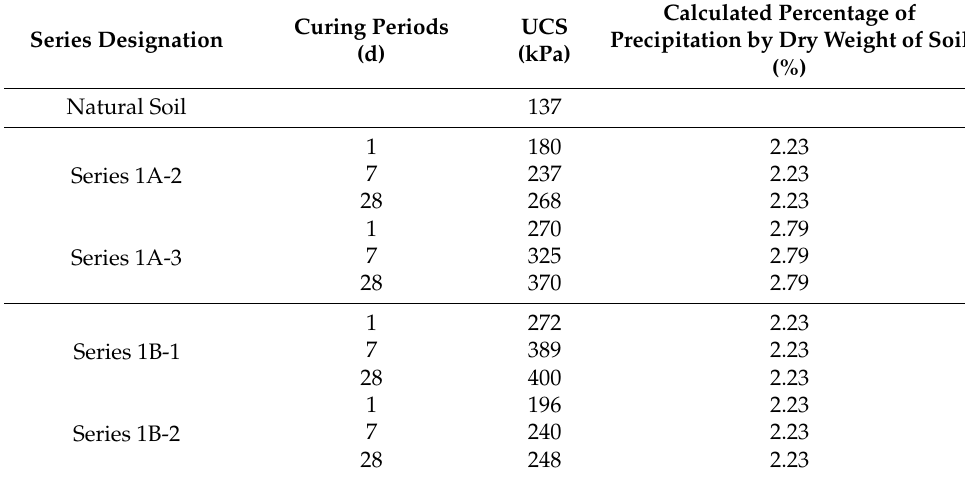
Table 7. The results of unconfined compression